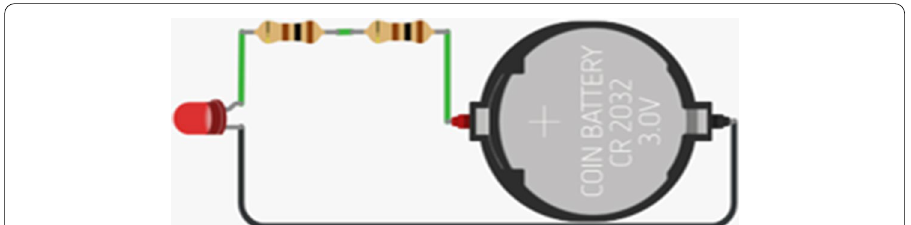
Fig. 2 Basic LED circuit. Components: LED, 2 10 Ohms resistor in series, and 3 V batteries (Made with